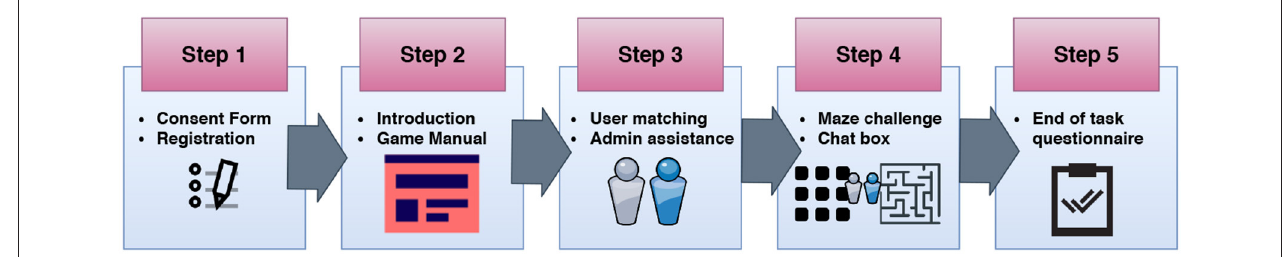
FIGURE 1 | System overview with the five steps of the study design. After registration, users arrive at an introductory page with relevant information about the task, and then they are matched in dyads on a first-in-first-out basis. Each team then proceeds to their dedicated virtual room where they cooperate to defuse the bomb in the maze within a given time frame. Finally, they fill out a questionnaire about their abilities and perceived collaboration